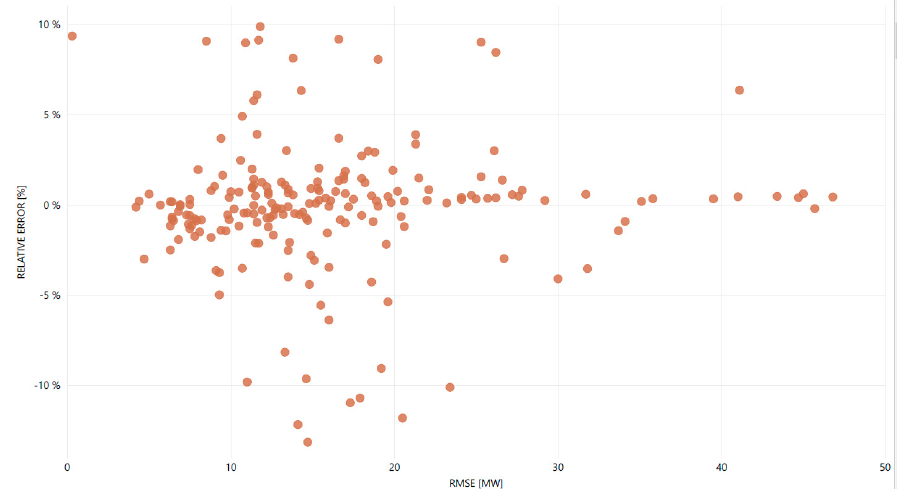
Figure 11. Daily aggregate net energy MRE vs. RMSE.